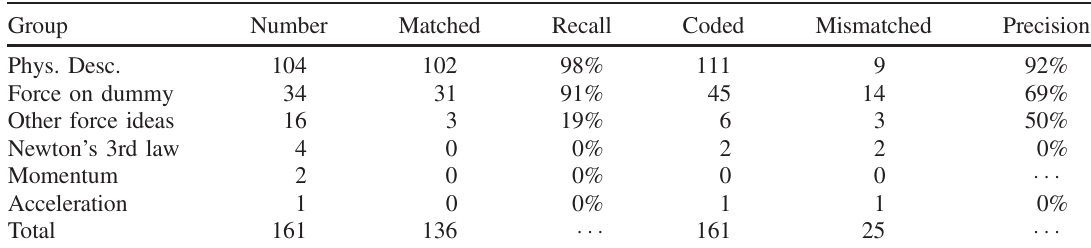
TABLE IV. Group-by-group matching for the crash test dummy activity. Group